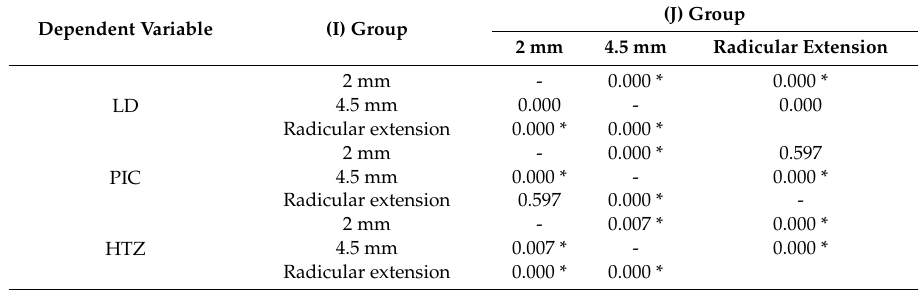
Table 3. Tukey HSD (honestly significant di ff erence) post-hoc pairwise comparison for fracture resistance at maximum load between the groups.